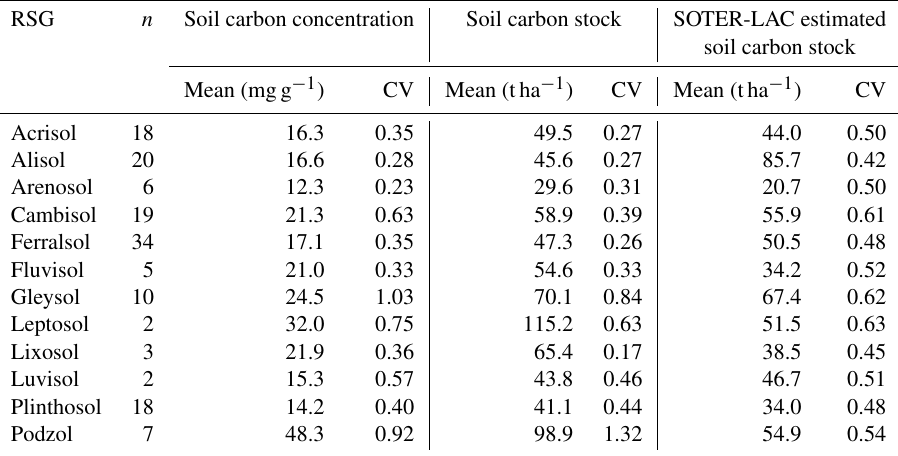
Table 9. Mean soil organic carbon stocks (0–30cm) for 12 RSGs examined in this study. Stocks from Batjes (1996) are also given for comparison. CV stands for coefficient of